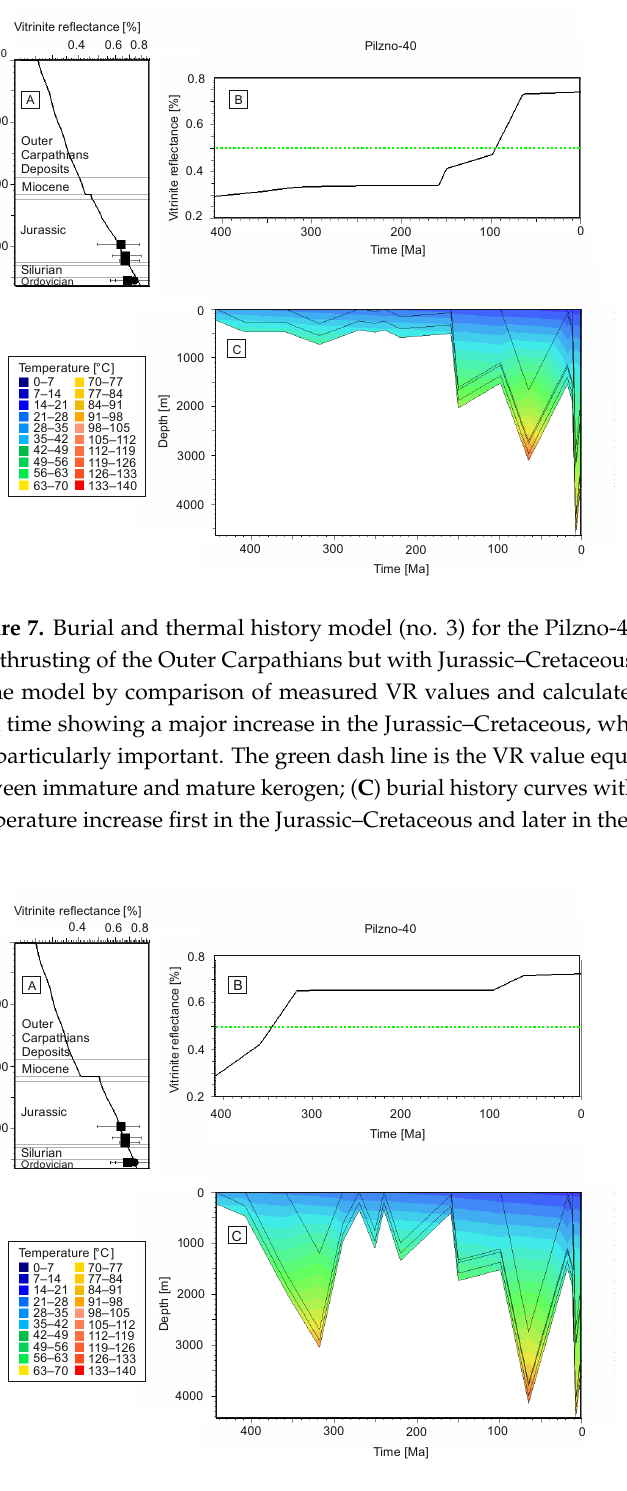
Figure 8. Burial and thermal history model (no. 4) for the Pilzno-40 well assuming Late Miocene overthrusting of the Outer Carpathians but with 2500 m Cretaceous and Variscan burial heating: ( A ) calibration of the model by comparison of measured VR values and calculated VR curve; ( B ) VR evolution with time. The green dash line is the VR value equals 0.5% that represents border between immature and mature kerogen; ( C ) burial history curves with temperature overlay. Note the temperature increase first in the Devonian–Carboniferous, then the Cretaceous, and, finally, the Late Miocene.